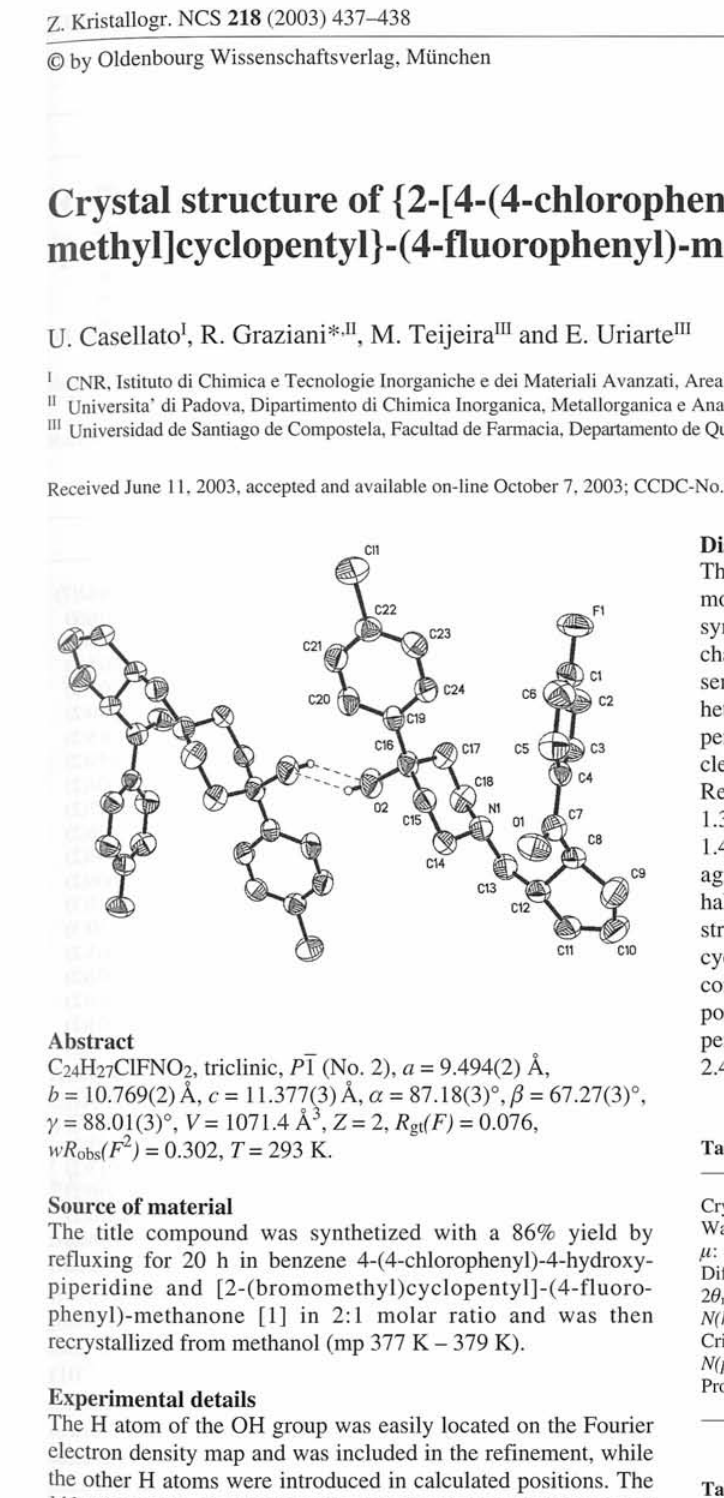
Table 2. Atomic coordinates and displacement parameters (in